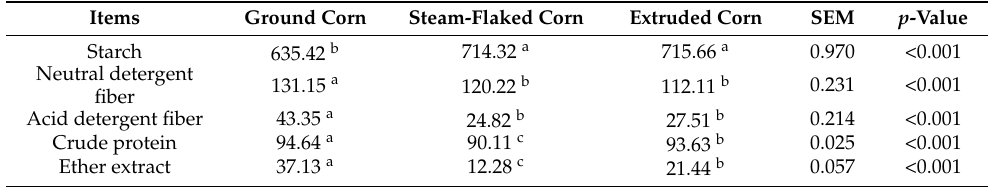
Table 1. Nutrient profiles of corn processed in different ways (g/kg DM).